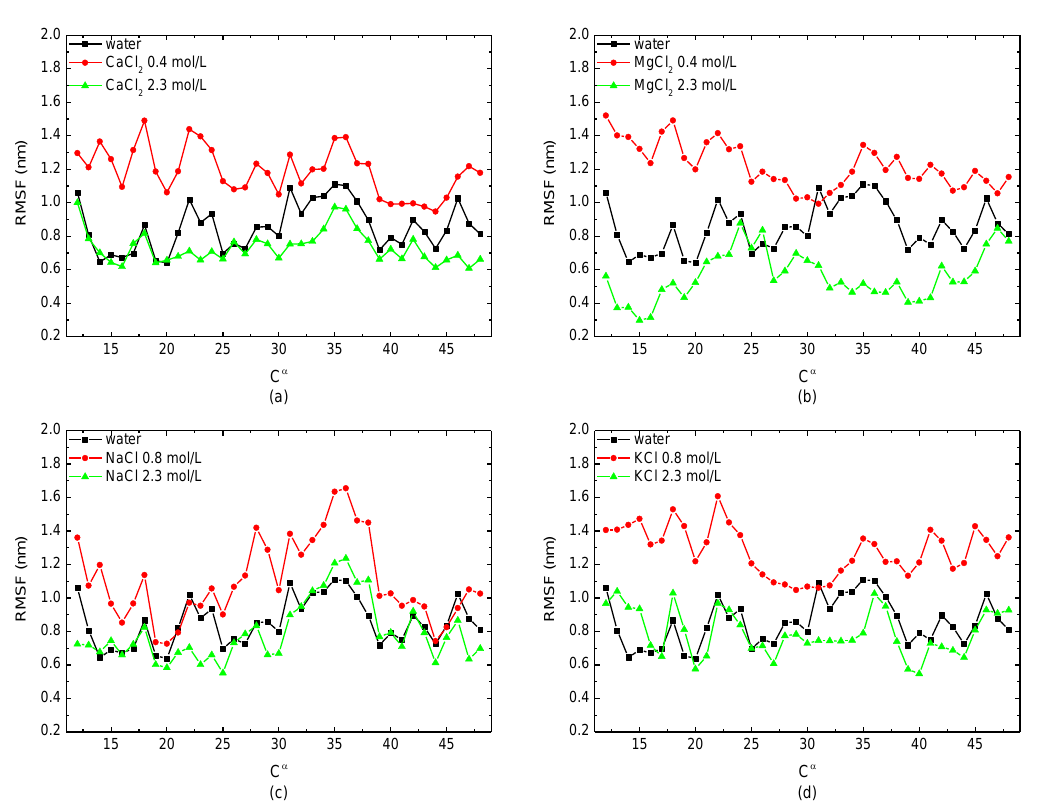
Figure 3. The root mean square fluctuation of the skeleton C α atom of the protein 1BBL immersed in ( a ) CaCl 2 , ( b ) MgCl 2 , ( c ) NaCl, and ( d ) KCl solutions, respectively. ( a ) CaCl 2 , ( b ) MgCl 2 , ( c ) NaCl, and ( d ) KCl solutions,